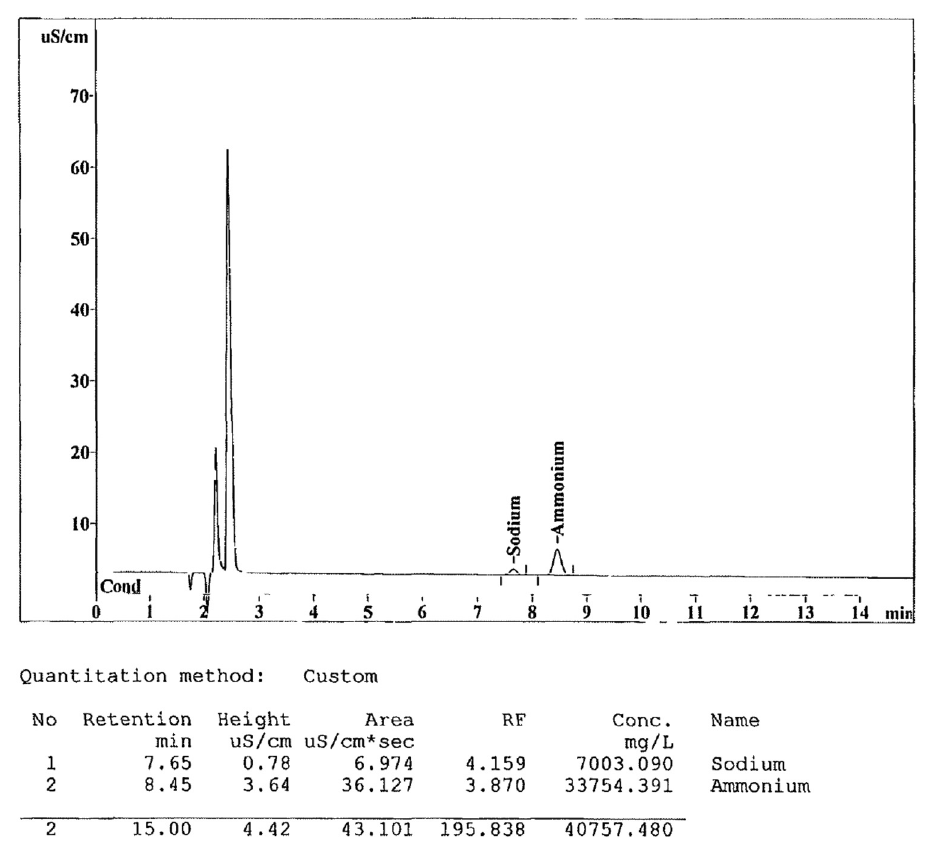
Figure A3: IC analysis of 7 - amino - 3 -[ sulfomethyl - 1 - H - tetrazol - 5 - yl - thiomethyl ]- 3 - cephem - 4 - carboxylate ammonium salt.